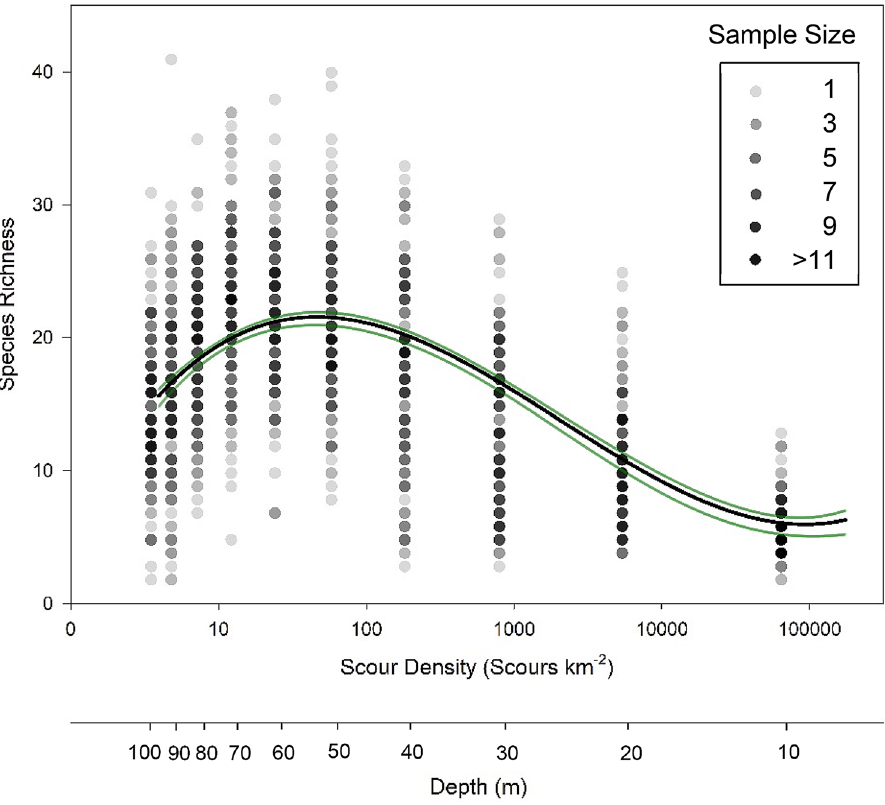
Figure 1. Relationship between species richness and disturbance. Line (model) of best fit was non-linear regression (cubic model, black line). Points are samples, with increasing shades of grey representing a greater number of samples. Green lines are 95% confidence intervals. Total sample number is 1500, evenly divided across 10 m depth intervals. Plot constructed in RStudio v1.1.463, https:// www. rstud io.